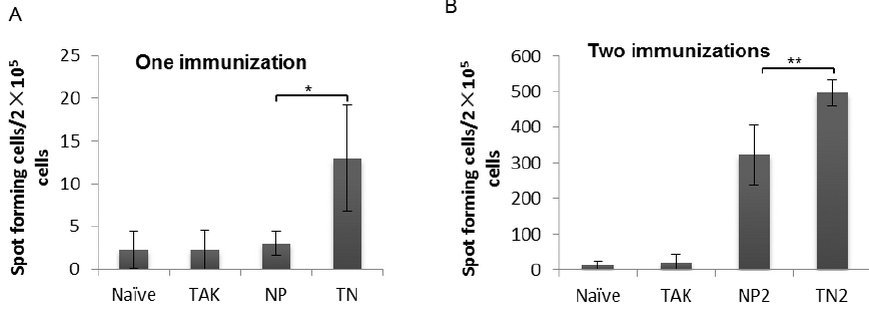
Figure 7. Effector functional characteristics of cells in NP-immunized mice with or without TAK-779 treatment compared with control group. Two weeks after TAK-779 cessation, individual spleens were collected from naïve mice, mice treated with TAK-779 (TAK), mice immunized once (NP) or twice with NP (NP2) and mice immunized once (TN) or twice (TN2) with NP and treated with TAK-779. Splenocytes were prepared and analyzed by IFN- γ ELISPOT assay upon restimulation with NP protein. Results are expressed as the mean ± SD of the number of positive spots per 2 × 10 5 cells. Results are representative of 2 independent experiments. * p ≤ 0.05, ** p ≤ 0.001.